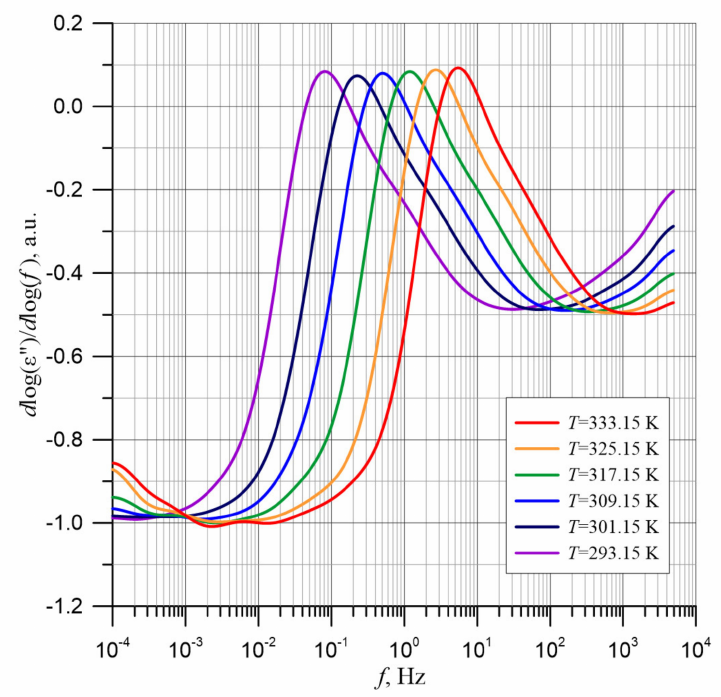
Figure 11. Frequency dependence of the derivative d (log ε (cid:48)(cid:48) )/ d (log f ) for the composite of pressboard, mineral oil and water nanoparticles for temperatures from 293.15 to 333.15 K.